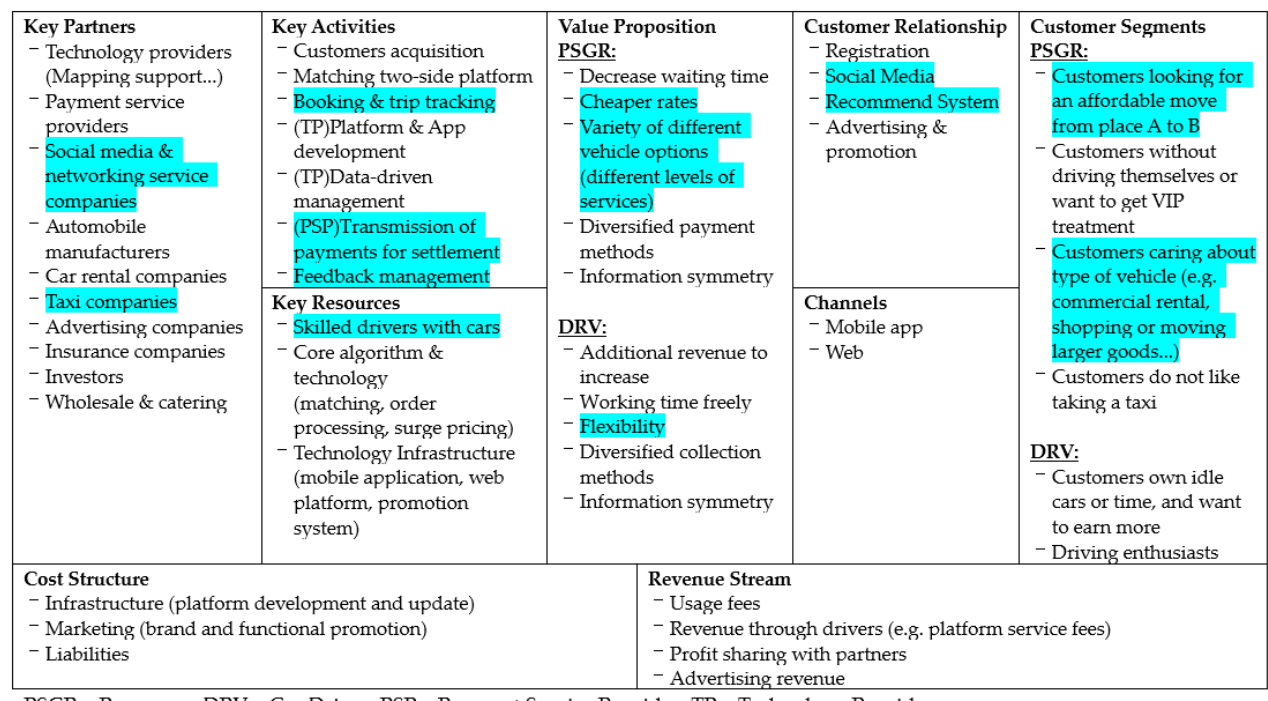
Figure 3. Canvas model of DiDi Chuxing platform. (Although both Uber and DiDi are ride-hailing platforms and have many similar attributes in their business models, we highlight the differences in the canvas building blocks in Figures 2 and 3).